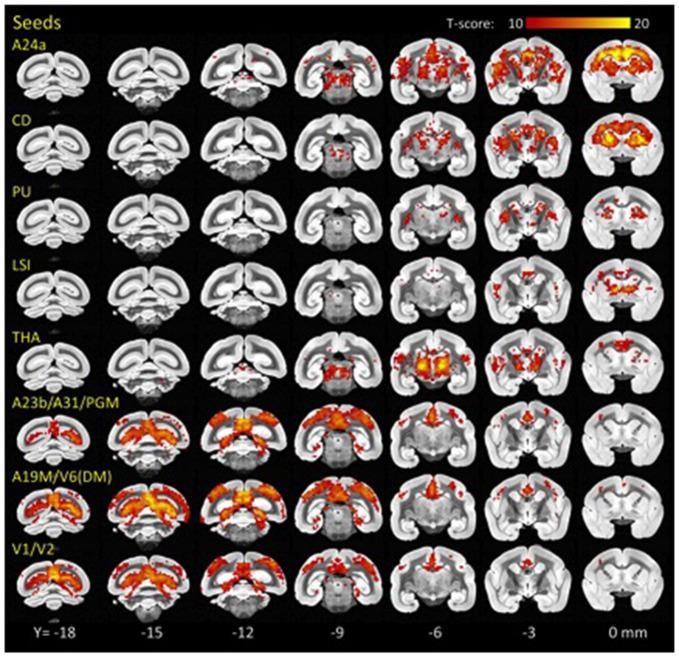
Hub-specific patterns of FC. Statistical significance of seed-voxel correlation patterns computed for each lFCD hub (yellow labels), superimposed on coronal MRI views of the marmoset brain. Numbers indicate the distance in mm to AC. Statistical model: within-subjects ANOVA. Statistical threshold: PFWE < 0.05.